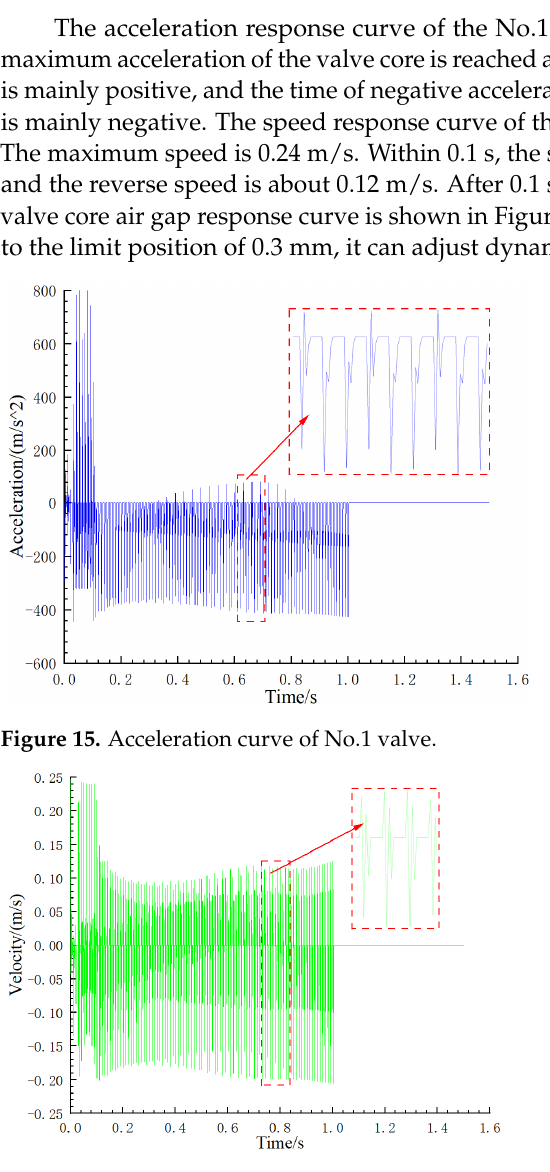
Figure 16. Speed curve of No.1 valve spool.